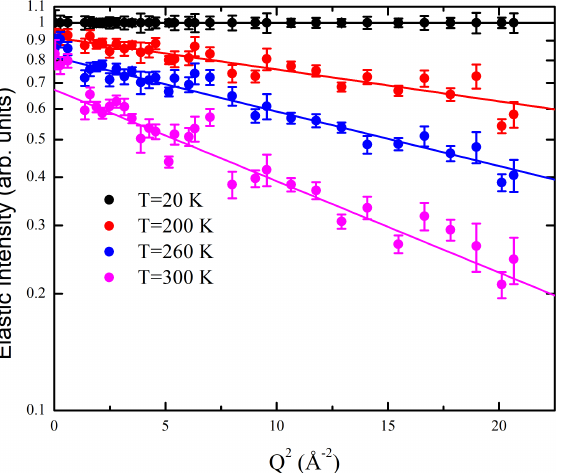
Figure 5. Normalized elastic scattered intensity (logarithmic scale) as a function of Q 2 for Tel22 in the presence of K + ions at four different temperatures. In this scale the Gaussian fit using Equation (2) over the [1.0–4.6] Å − 1 Q range appears as a linear